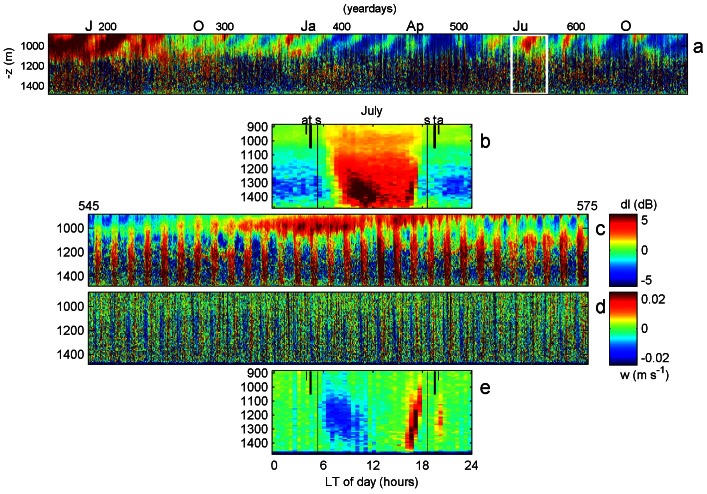
Overview of relative echo intensity data (dI), amount of plankton, and vertical current data (w), movement of plankton, from an upward looking ADCP in the sub-tropical Canary Basin (at 22.5°N, 27°W, mooring LOC163 (Table 1), ranging vertically between z = −1476 and −886 m.Below −1150 m noise is increased, due to lower amounts of plankton once they have migrated upwards after dusk. Time in 2007 is yearday +365. (a) Entire 18 months of depth versus local solar time series of plankton, or echo intensity, relative to its time mean. (b) Monthly averaged summer time data from white rectangle in a. Symbols ‘s’ indicate local sunrise and sunset, ‘t’ nautical twilight and ‘a’ astronomical twilight. (c) Month of July raw data (rectangle in a.) of which b. is the average. (d) as c., but for w. (e) as b., but for w.